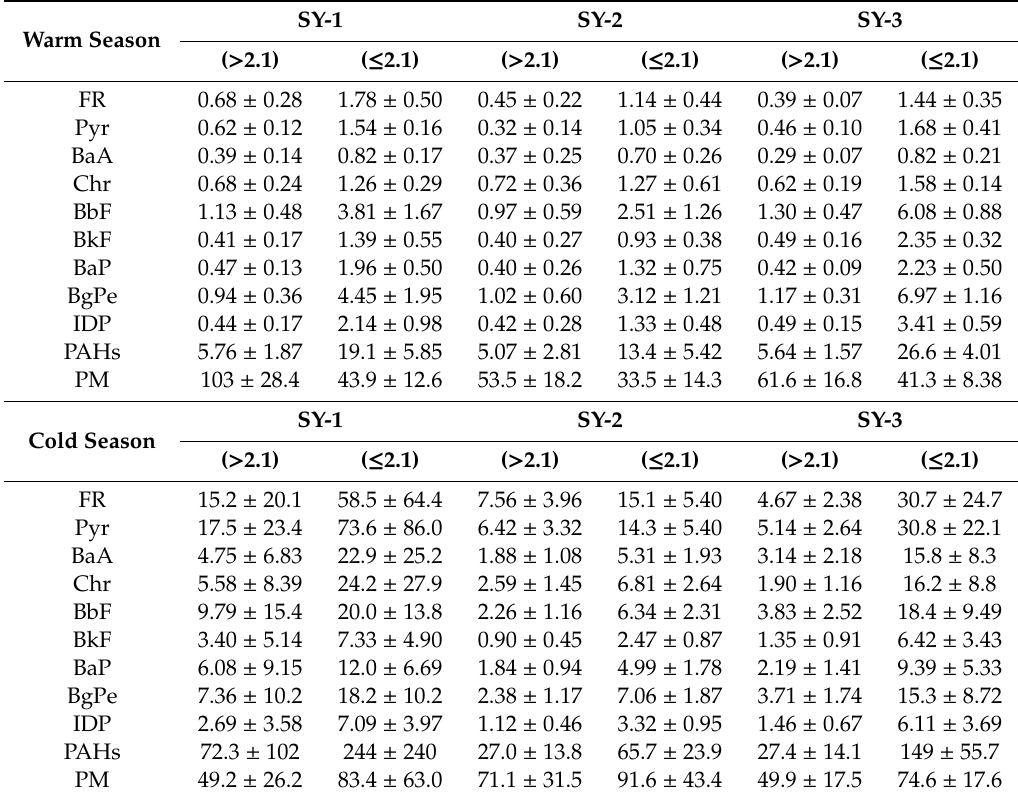
Table 1. Mean concentration of PAHs (ng m − 3 ) and PM ( µ g m − 3 ) at three sites in Shenyang during the sampling